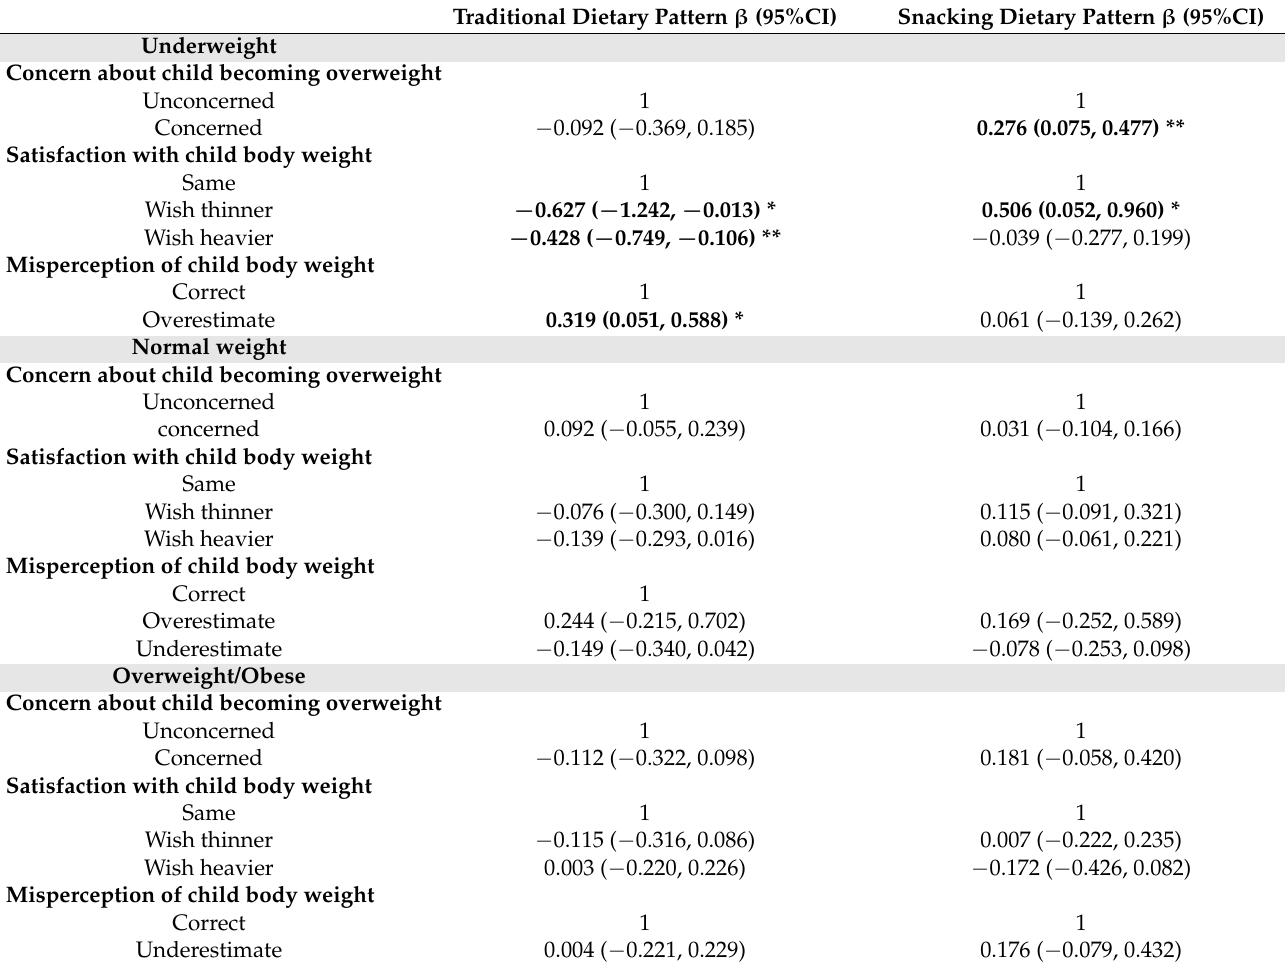
Table 3. Linear regression relationships between parental weight perceptions and children’s dietary patterns among different ZBMI weight status of